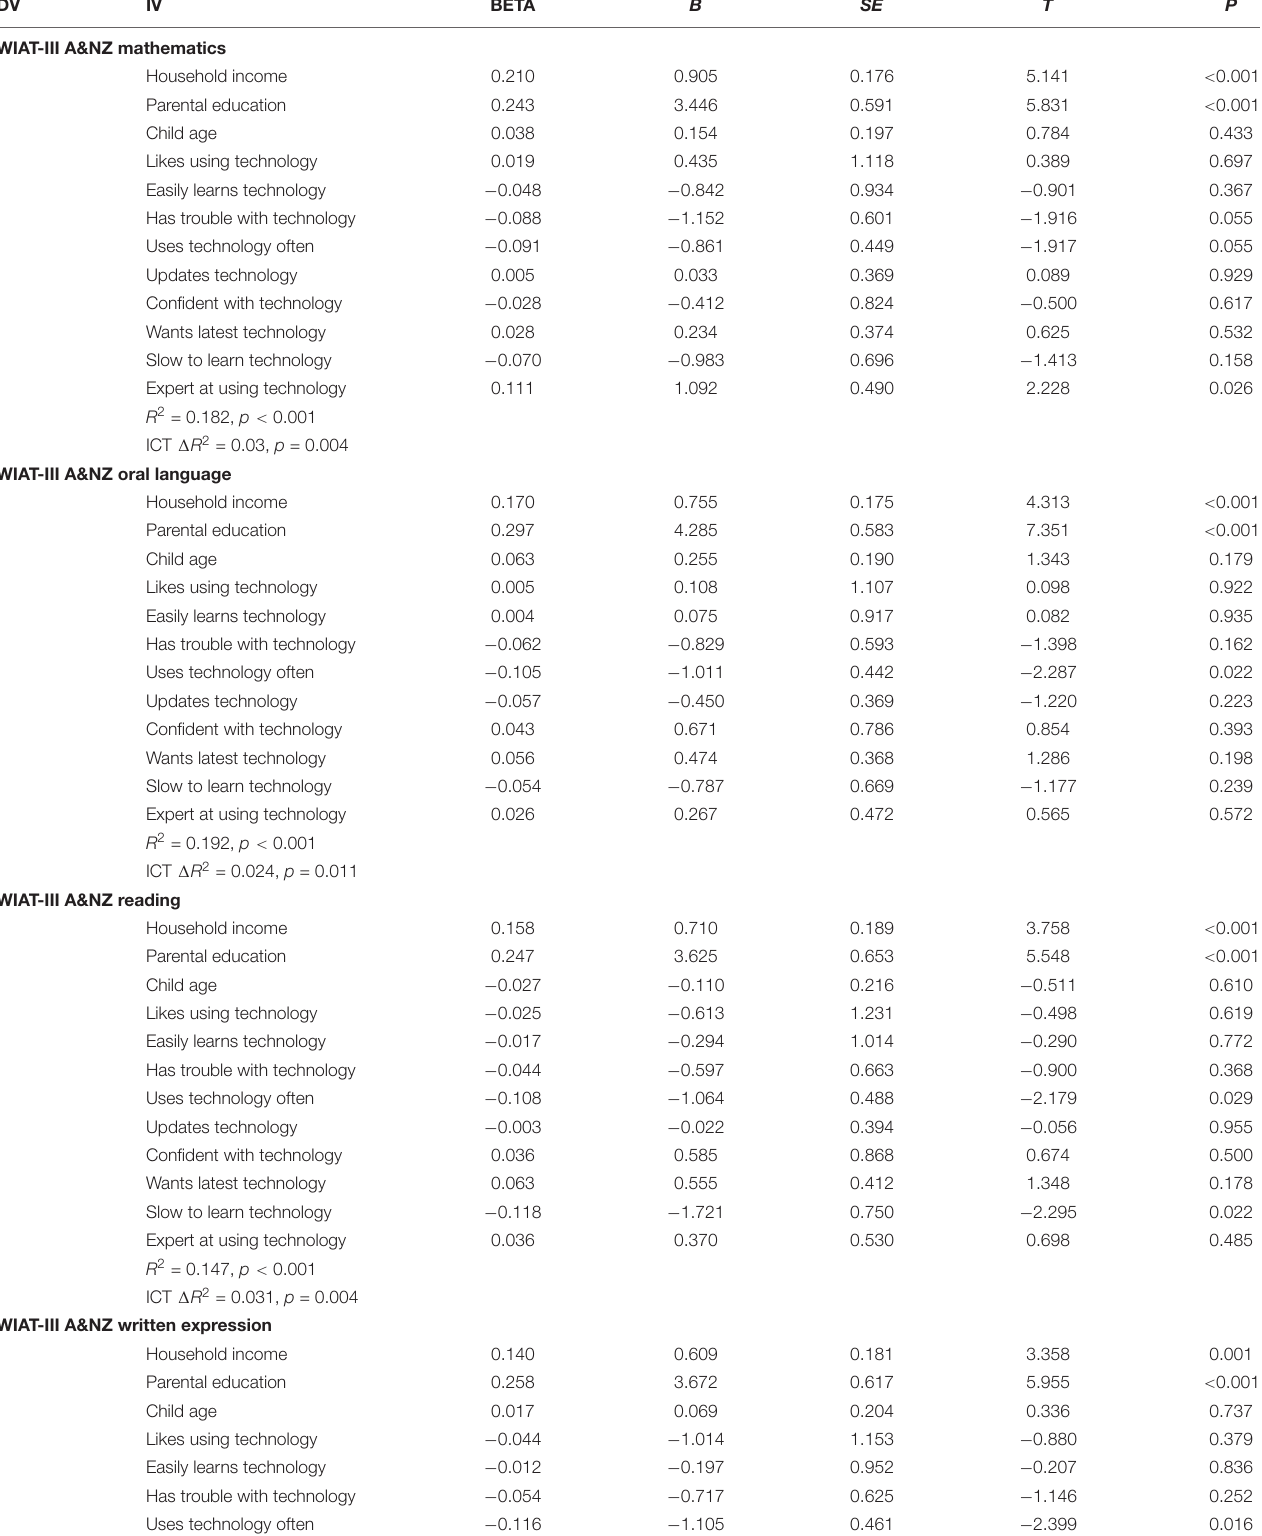
TABLE 4 | Sequential multiple regression of ICT Aptitude for WIAT-III A&NZ Academic indices.